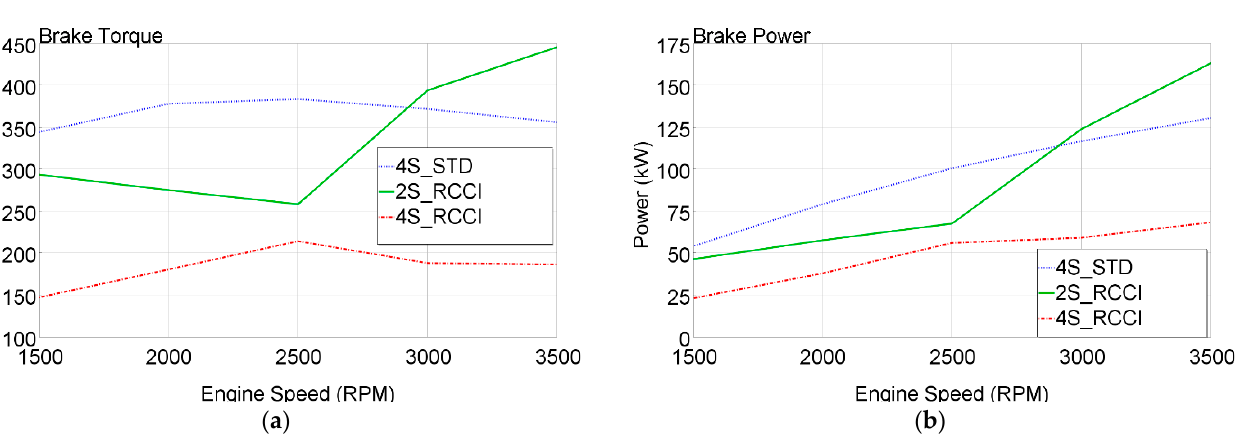
Figure 9. Brake torque ( a ) and brake power ( b ) comparison, base diesel engine, 4-stroke RCCI engine and 2-stroke RCCI engine. Operating point 1500–3500 rpm at full load.